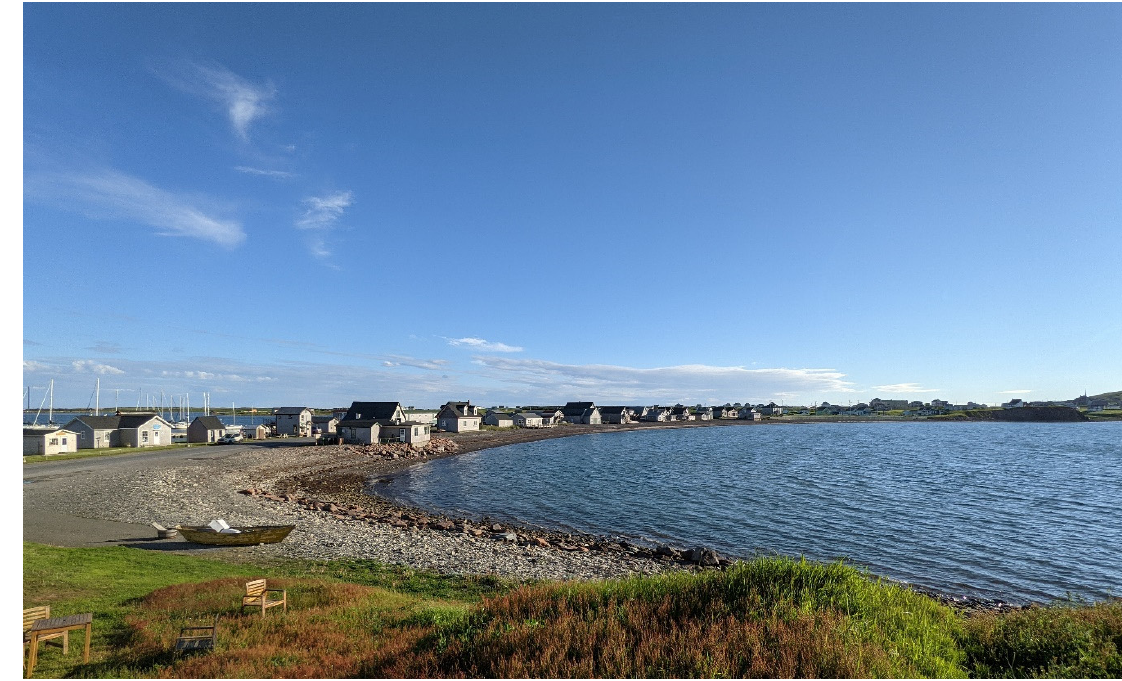
Figure 3 : The La Grave historical site (Photography Dominic Lapointe). Figure 3. The La Grave historical site (Photography Dominic